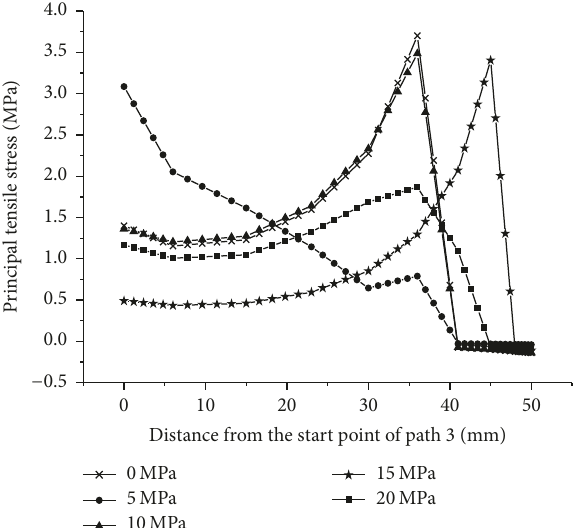
Figure 25: Comparison of the principal tensile stress generated along path 3 from corrosion-induced expansion when the dis- placement resulting from corrosion-induced expansion reaches 0.005 mm.